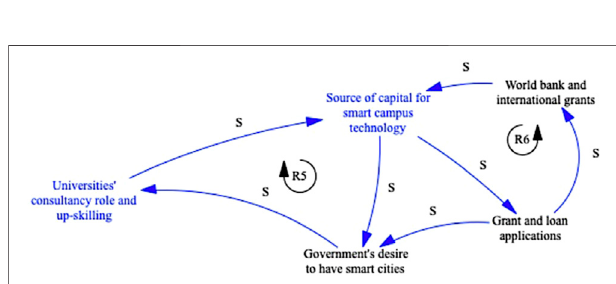
FIGURE 9 | System archetype 4- The role of smart campus in smart cities development. Source: Authors.